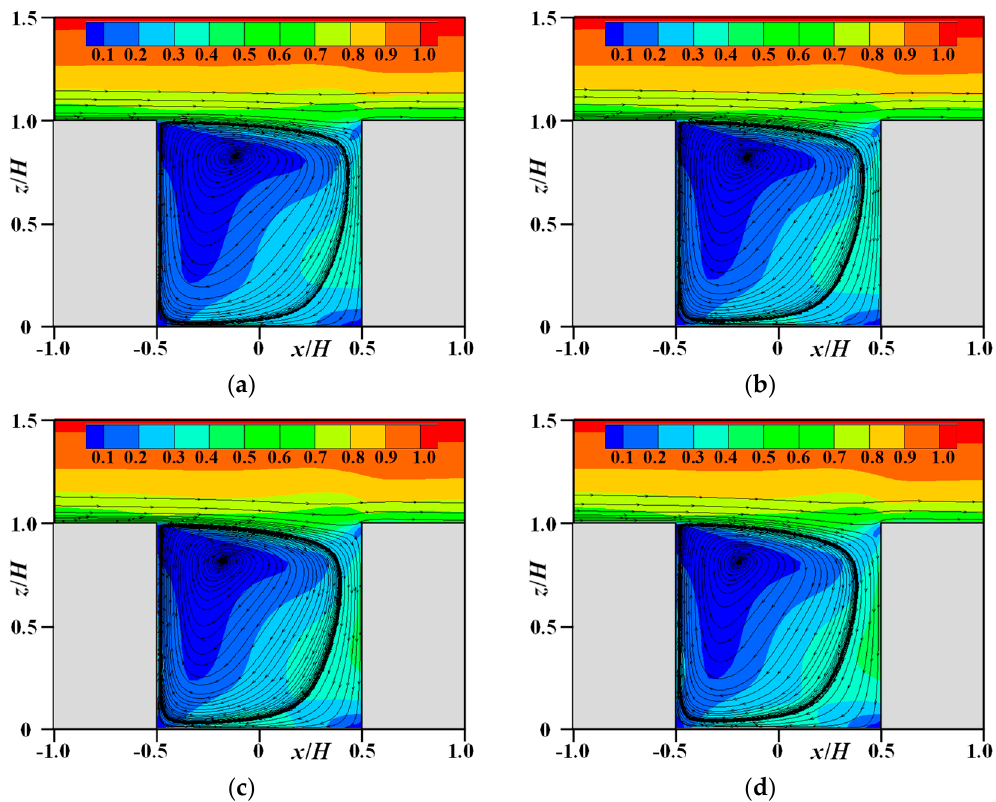
Figure 6. Mean streamlines and normalized velocity magnitude ( U 2 + V 2 + W 2 ) 0.5 / U H in symmetry plane ( y = 0, target street canyon (TSC)): ( a ) GH-30; ( b ) GH-40; ( c ) GH-50; ( d ) GH-60.